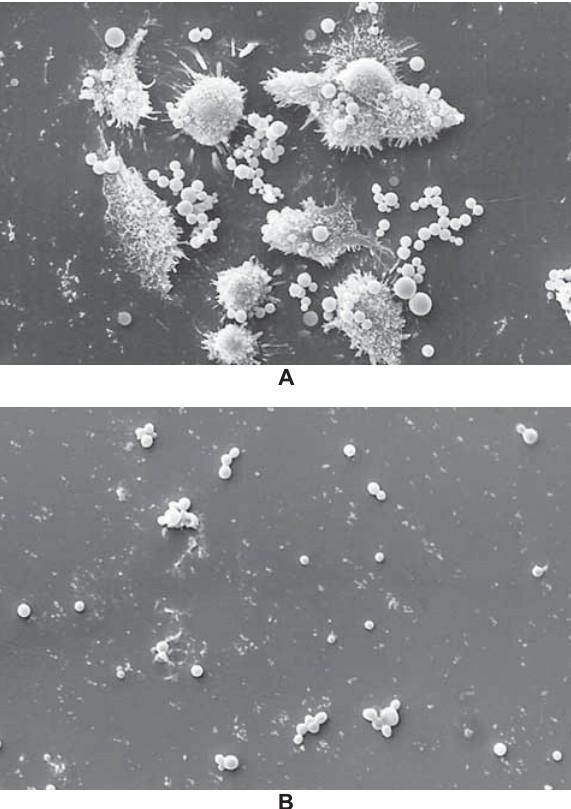
Figure 2- Panel of SEM micrographs representative of cell morphology. A - Group 3 (40 s); B - Group 4 (60 s). Presence of spindle-shaped cells organized in dense (cid:17)(cid:4)(cid:25)(cid:26)(cid:6)(cid:13)(cid:8)(cid:27)(cid:11)(cid:14)(cid:15)(cid:12)(cid:10)(cid:16)(cid:10)(cid:17)(cid:7)(cid:6)(cid:11)(cid:9)(cid:7)(cid:16)(cid:17)(cid:10)(cid:18)(cid:1)(cid:7)(cid:3)(cid:10)(cid:4)(cid:17)(cid:19)(cid:11)(cid:20)(cid:21)(cid:22)(cid:23)(cid:23)(cid:23)(cid:24)